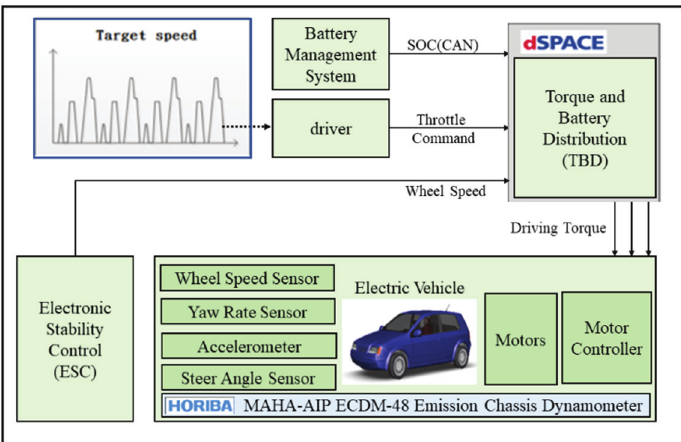
Figure 7. Architecture of the hardware-in-the-loop experiment.